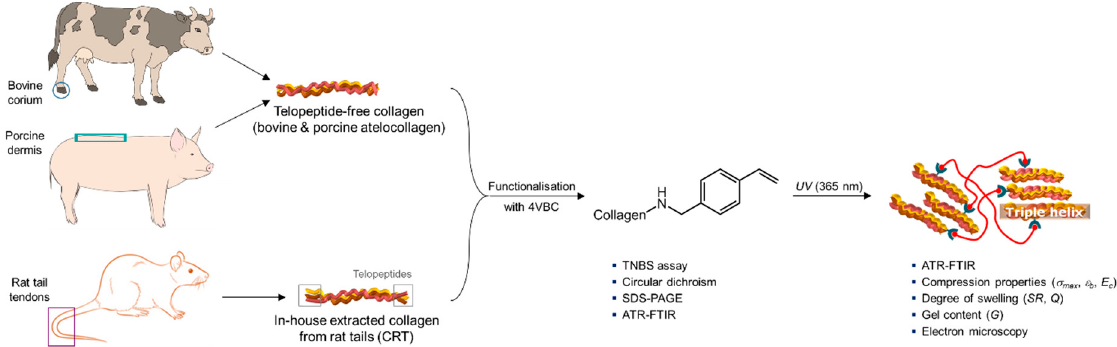
Figure 1. Overview of the research strategies and experimental methods. The molecular characteristics of commercially available bovine and porcine atelocollagen were compared with those of research-grade collagen extracted in-house from rat tails. Covalent functionalisation with 4VBC and UV curing were carried out and the effect of raw material molecular characteristics on the manufacturability and macroscopic properties of UV-cured hydrogel networks was assessed.